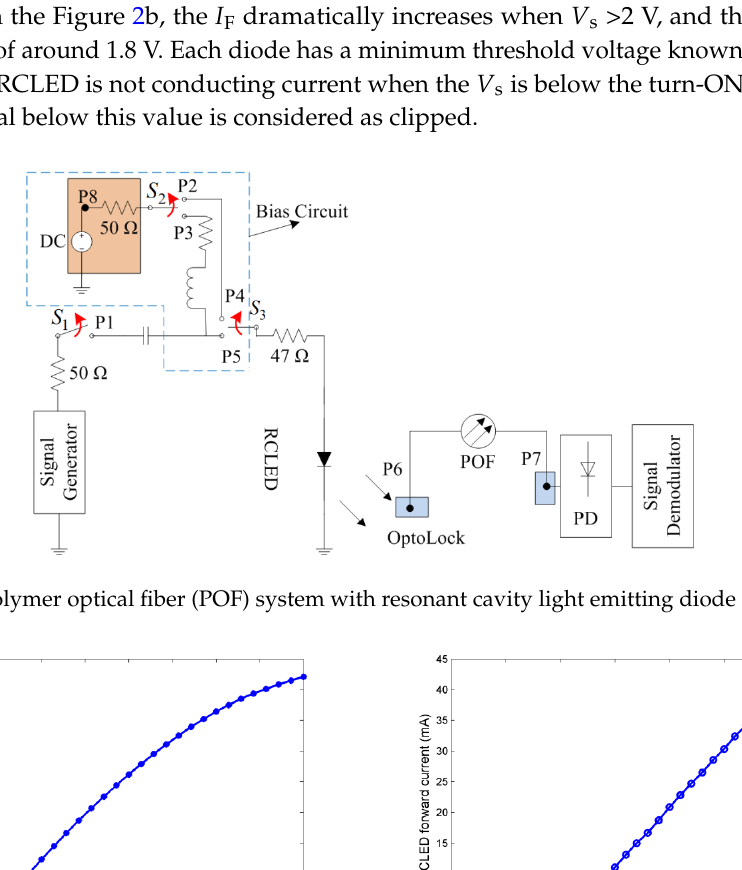
Appl. 2016 , 6 , 260 3 of 15